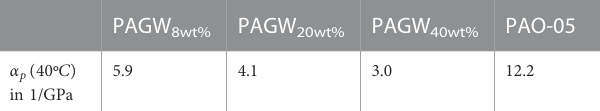
TABLE 3 Derived pressure-viscosity coef fi cients.